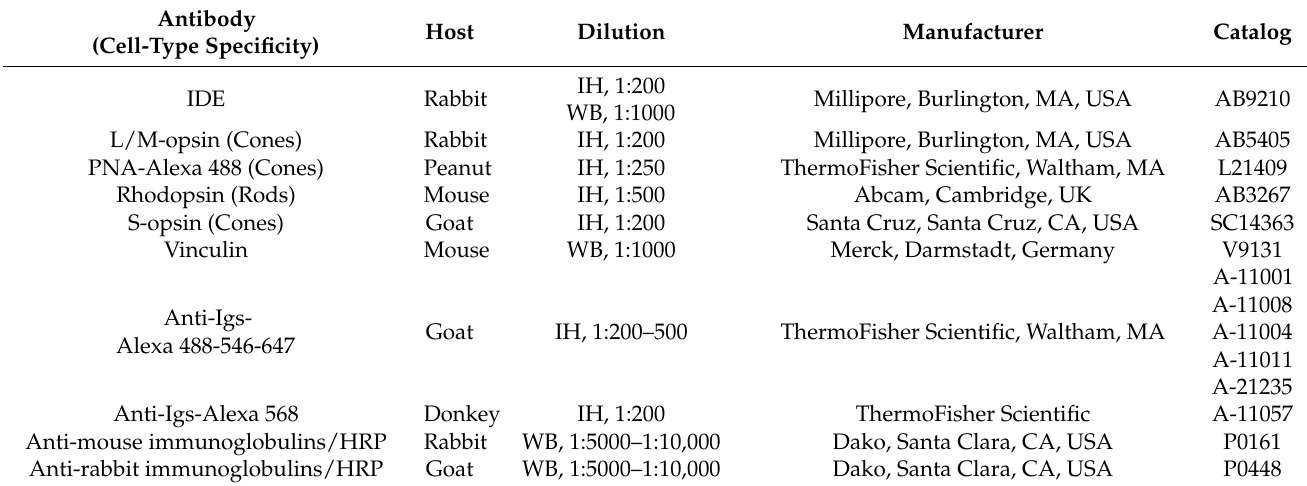
Table 2. Antibodies used in the